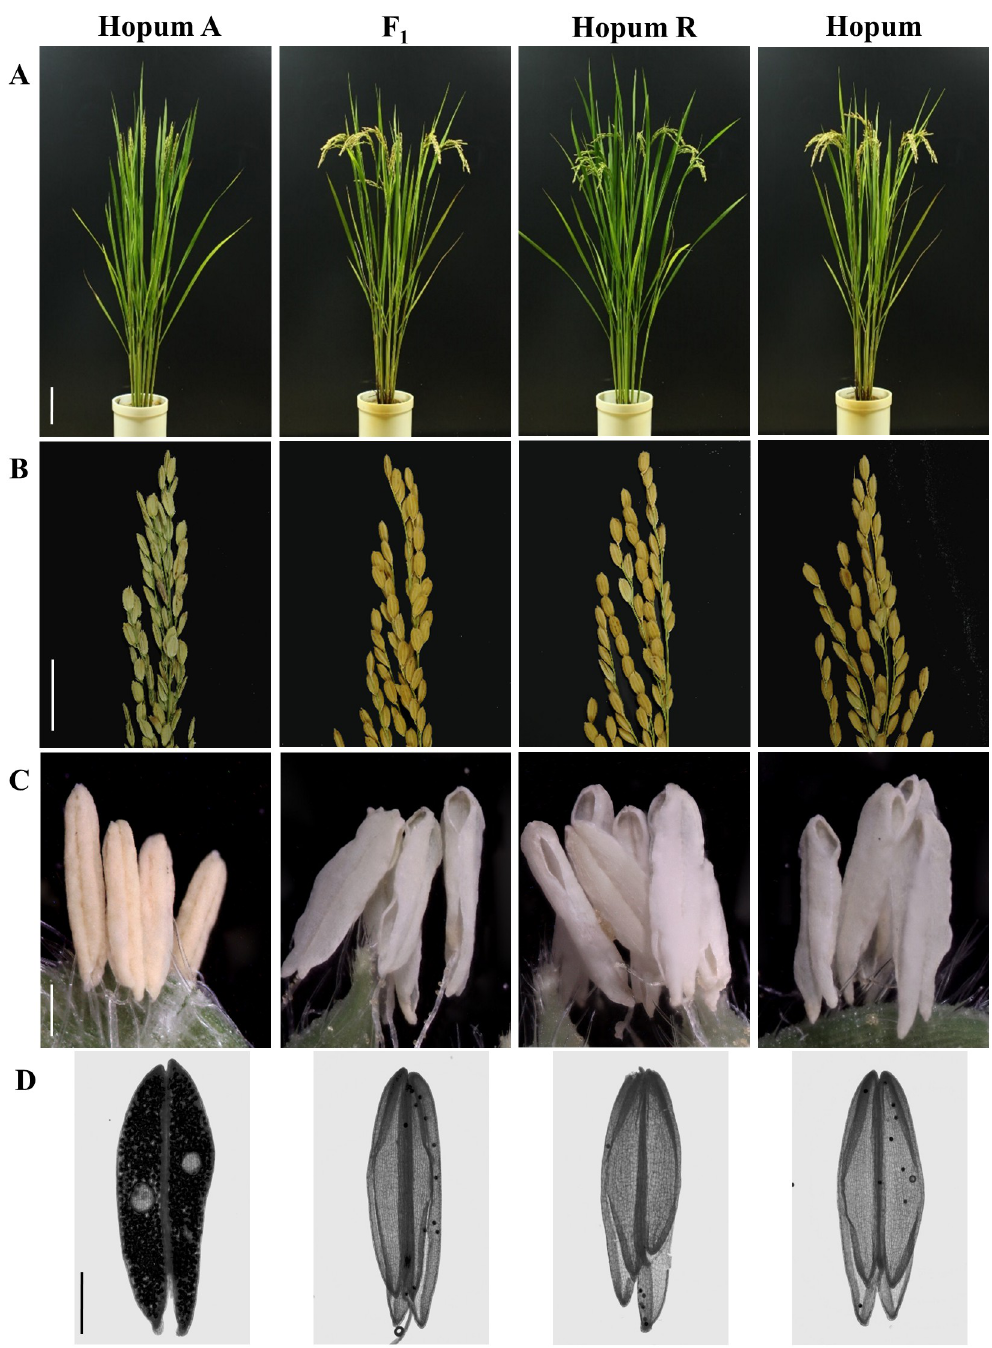
Fig 1. Phenotypic comparisons among the Tetep-CMS line, restorer line, and their F 1 progeny. (A) Plant phenotype before harvest. Scale bar = 10 cm. (B) Seed setting. Scale bar = 2 cm. (C) Anthers 24 h after flowering. Scale bar = 500 μ m. (D) 0.1% I 2 -KI stain after flowering. Scale bar = 500 μ